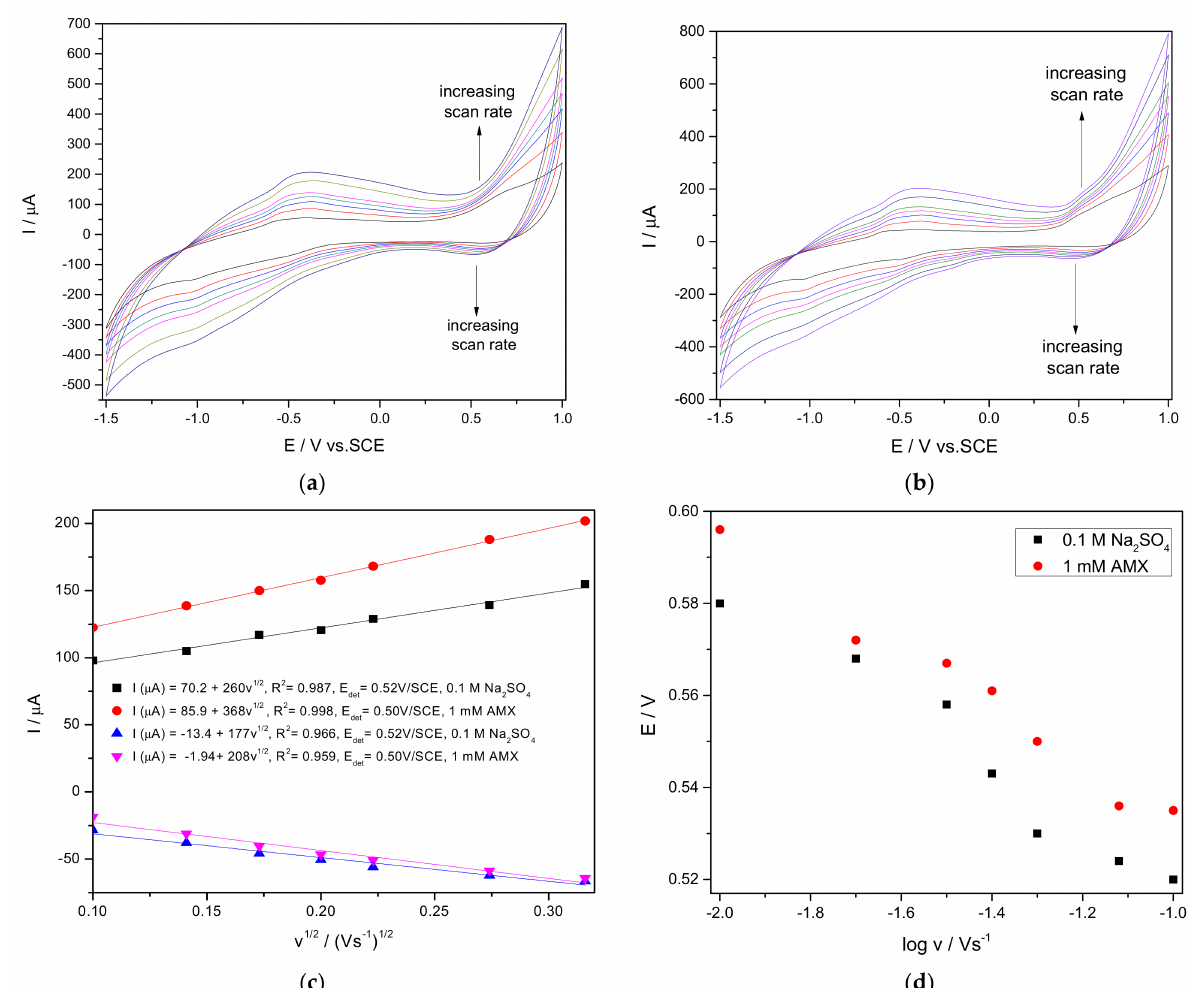
Figure 7. Cyclic voltammograms recorded at CuBi/CNF modified paste electrode in 0.1 M Na 2 SO 4 supporting electrolyte ( a ) and 1 mM AMX ( b ) at various scan rates: (1) 10, (2) 20, (3) 30, (4) 40, (5) 50, (6) 75, and (7) 100 mVs − 1 . Dependence of anodic peak current vs. square root of scan rate ( c ). Dependence of anodic and cathodic peak potentials vs. logarithm of the scan rate ( d